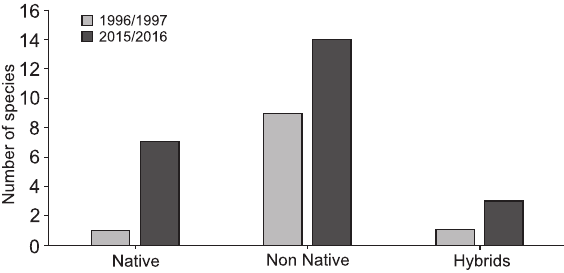
Figure 2. Number of fish species escaped (native, non-native and hybrid) in the Lower and Middle Paranapanema River basin during the floods of 1996/1997 (Orsi and Agostinho 1999) and